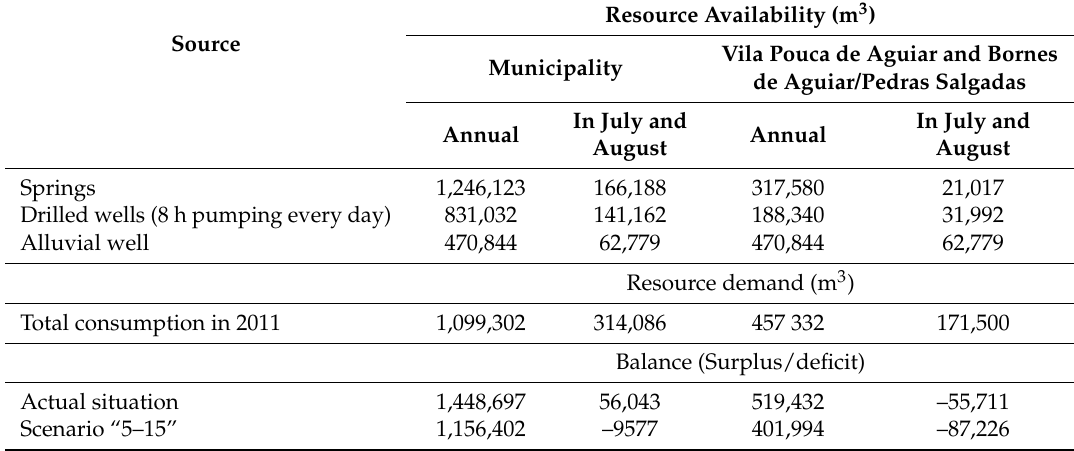
Figure 6. Spatial distribution of groundwater consumption within the Vila Pouca de Aguiar municipality (graduated yellow circles). The circles are plotted over the spatial distribution of annual spring discharge (average yield per spring) to expose the distortion between resource availability and demand. For example, Vila Pouca de Aguiar has the largest demand for groundwater but is located where spring discharge is low. Conversely, Alfarela de Jales or Vreia de Jales are low demanding villages located in a region with large resource availability. Table 1. Relationship between groundwater resource availability and groundwater consumption in the entire Vila Pouca de Aguiar municipality and the two largest towns, considering the annual resources and total consumptions as well as the July–August counterparts. The scenario “5–15” refers to the expected 5% consumption increase and 15% precipitation decrease over the next two